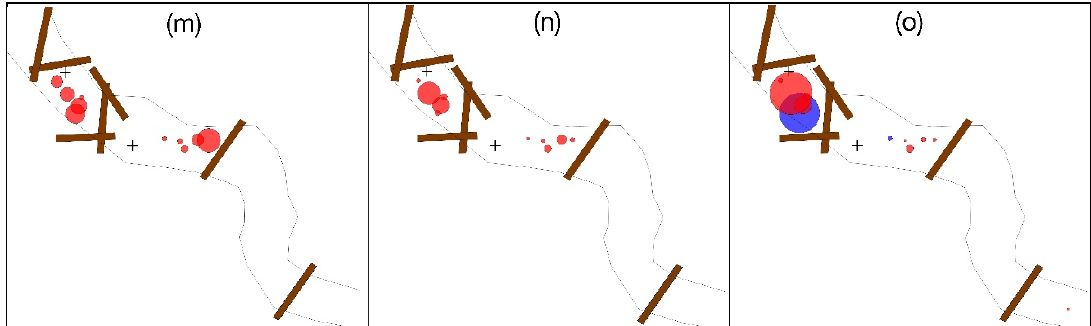
Figure 9. Vertical Flux (m / d) at the Kingfisher Treatment site by depth layer and date. Maps in ( a – o ) are arranged chronologically in horizontal rows by date, with each column representing a layer (0–10 cm on the left, 0–20 cm in the middle, and 10–20 cm on the right). For scale, red and blue dots in map legend, in upper left panel (a), represent 1.0 m / d flux. Plunge-pools 4–6 (PP4–PP6) and a pocket-water structure (PW) are labelled in ( a ).